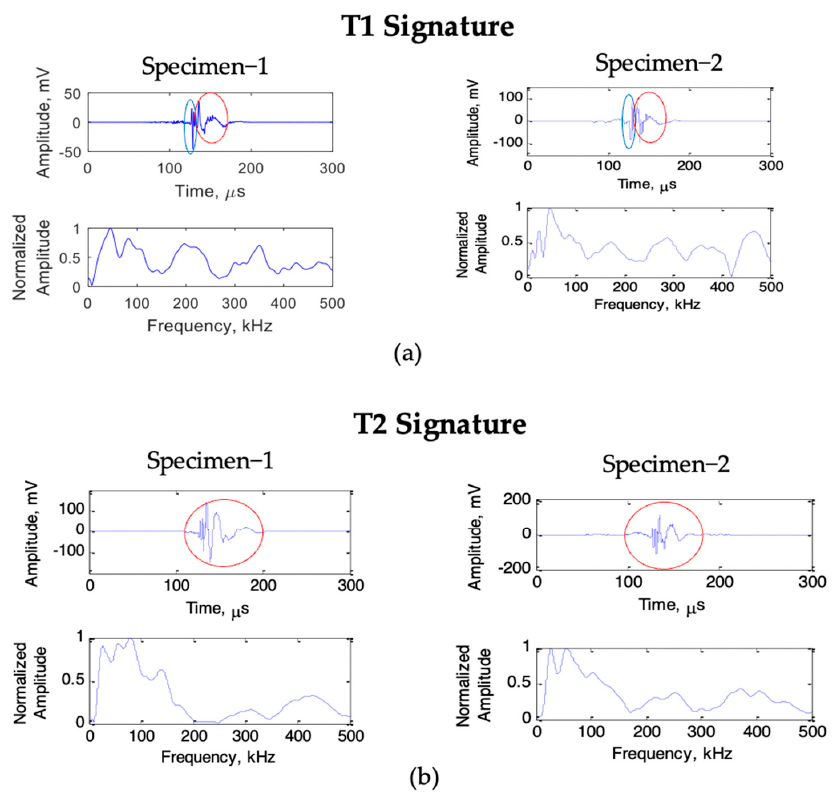
Figure 18. The repeatability assessment of T1 and T2 AE signal signatures. Another specimen with the same aluminum 2024–T3 material was tested under fatigue loading and compared with the present experimental results. A close match of results was observed. ( a ) T1 signature in specimen 1 and specimen 2 at PWAS–2: separation of two wave packets is visible in both signals; ( b ) T2 signature in specimen 1 and specimen 2 at PWAS–2: only the single wave packet is visible in both signals; similar peaks and valleys are observed.